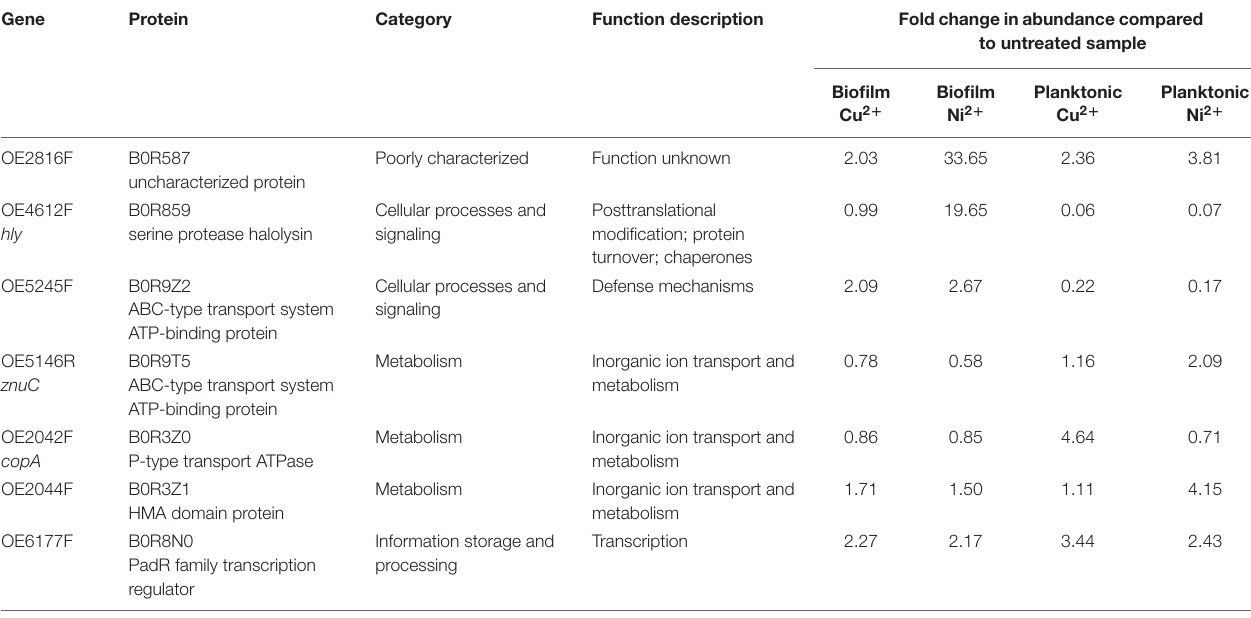
TABLE 2 | Target genes selected for gene deletion studies based on our proteomic data. Gene